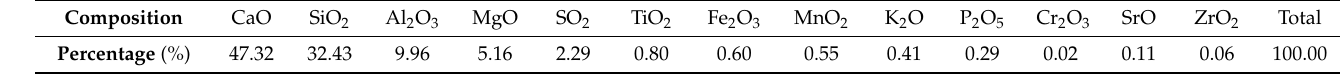
Table 1. The chemical composition of GGBFS.